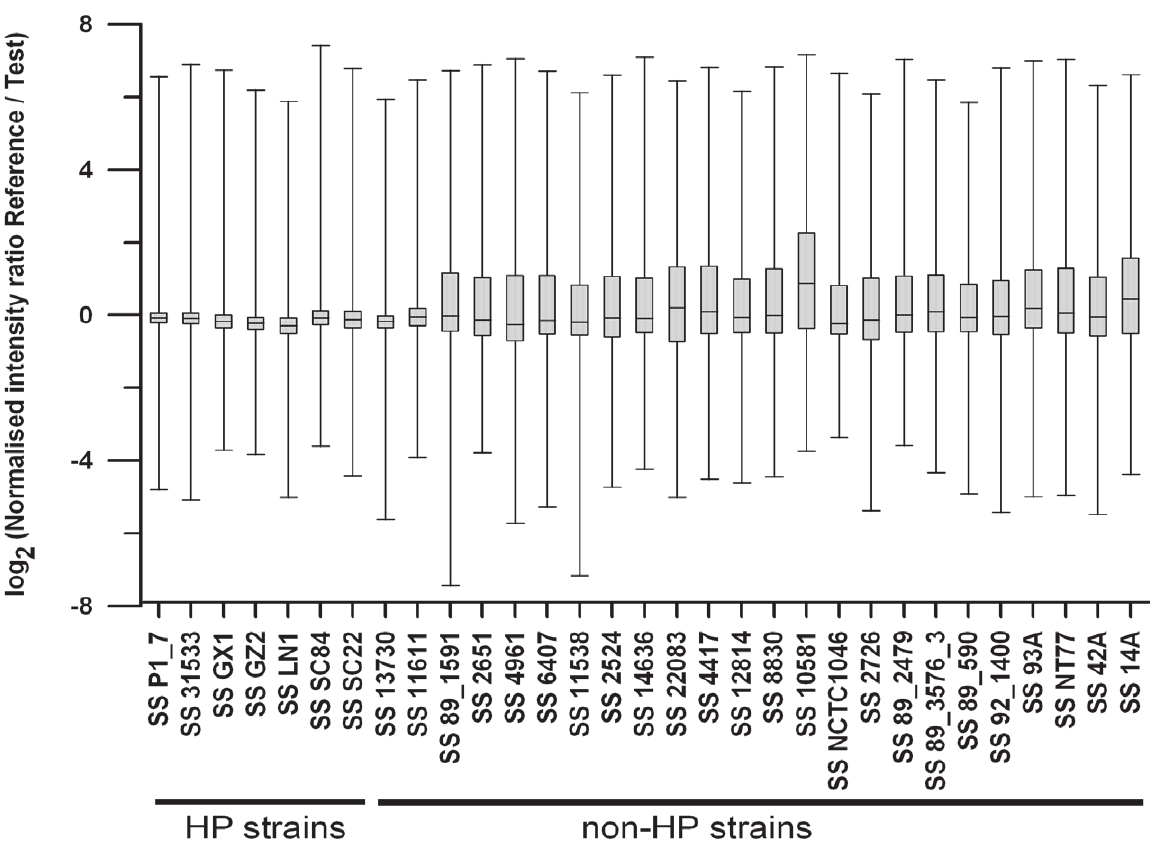
Figure 1. Box-Whisker Plot illustration on the distribution of hybridization intensities of the 760,000 probes for the 31 test S.suis strains. The signal ratios were plotted against each strain. The x-axis represents the microarray data of individual strains, while the y-axis represents the log 2 transformed feature signal ratio. The box is defined by the lower and upper quartiles, and the line in the center of the box is the median. Whiskers represent the rest of the distribution, with caps at the ends of each box indicating the extreme values (minimum and maximum). The strain name corresponding to each microarray is shown at the bottom of the plot.